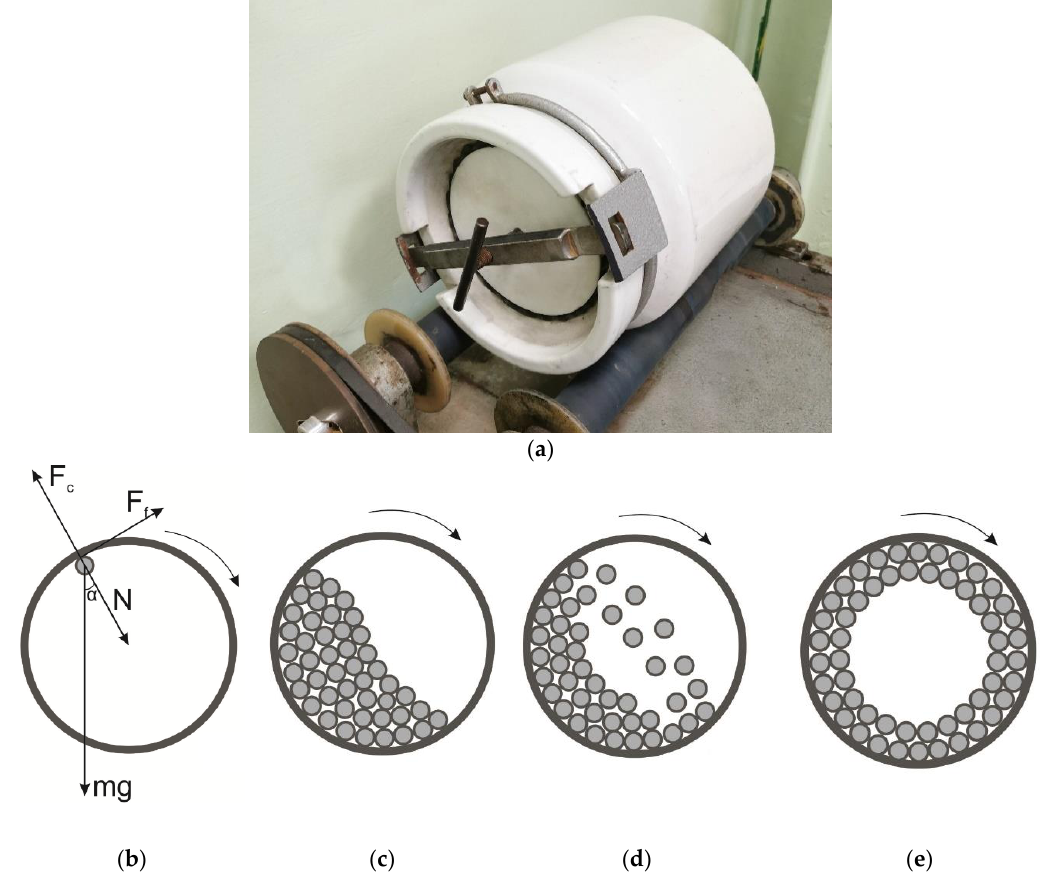
Figure 3. A real-world example ( a ), the effect of forces ( b ) and the types of motion of grinding bodies in a ball mill: ( c )—rolling over; ( d )—falling; ( e )—rolling.